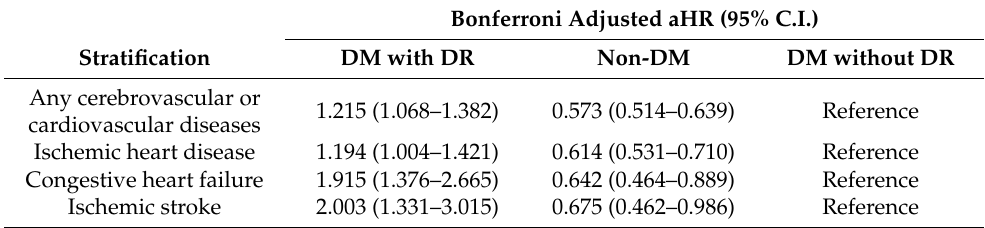
Table 6. Stratified analysis of CVD among all study